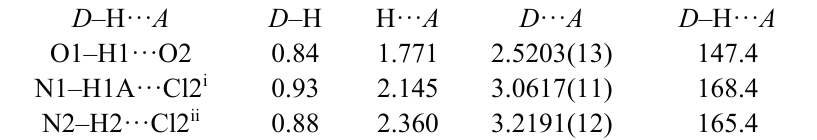
Figure 10. Crystal packing pattern showing intermolecular H-bonding to chloride ions in dimers of 13 (dashed lines: hydrogen bonding). Table 6. Hydrogen-bond geometry (Å, °) for 13